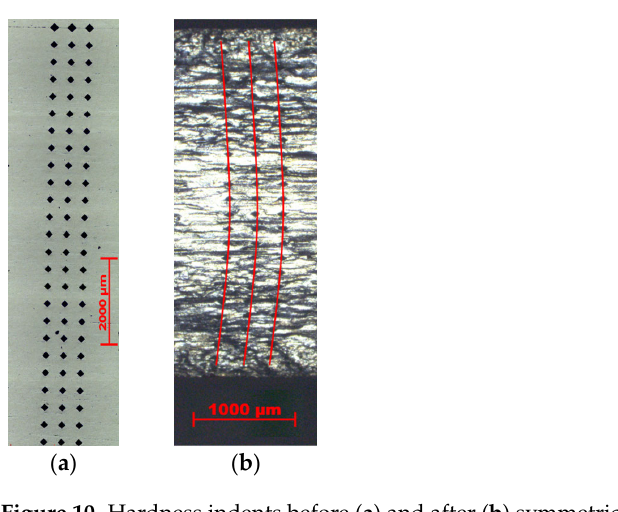
Figure 9. Hardness indents before ( a ) and after ( b ) asymmetric cold rolling.